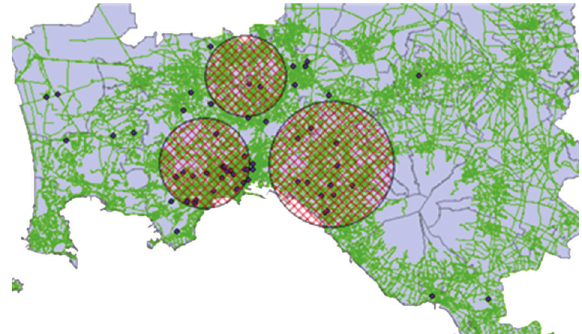
Figure 5: Analysis of the spatio-temporal evolution of hotspots detected in two consecutive periods.